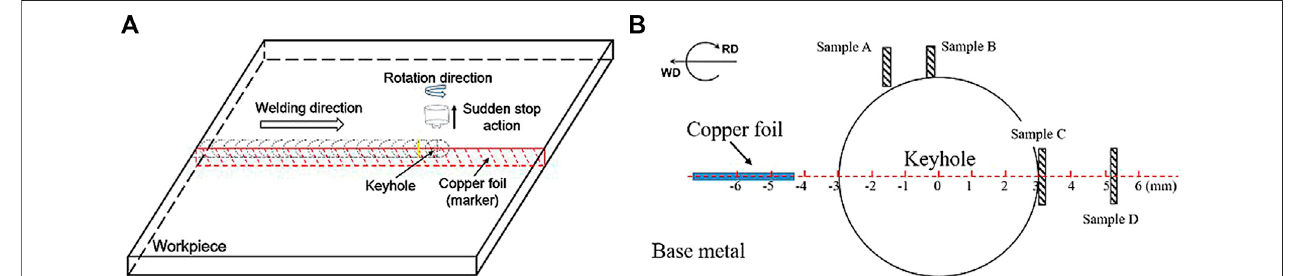
FIGURE 2 | Schematic illustration FWS process.